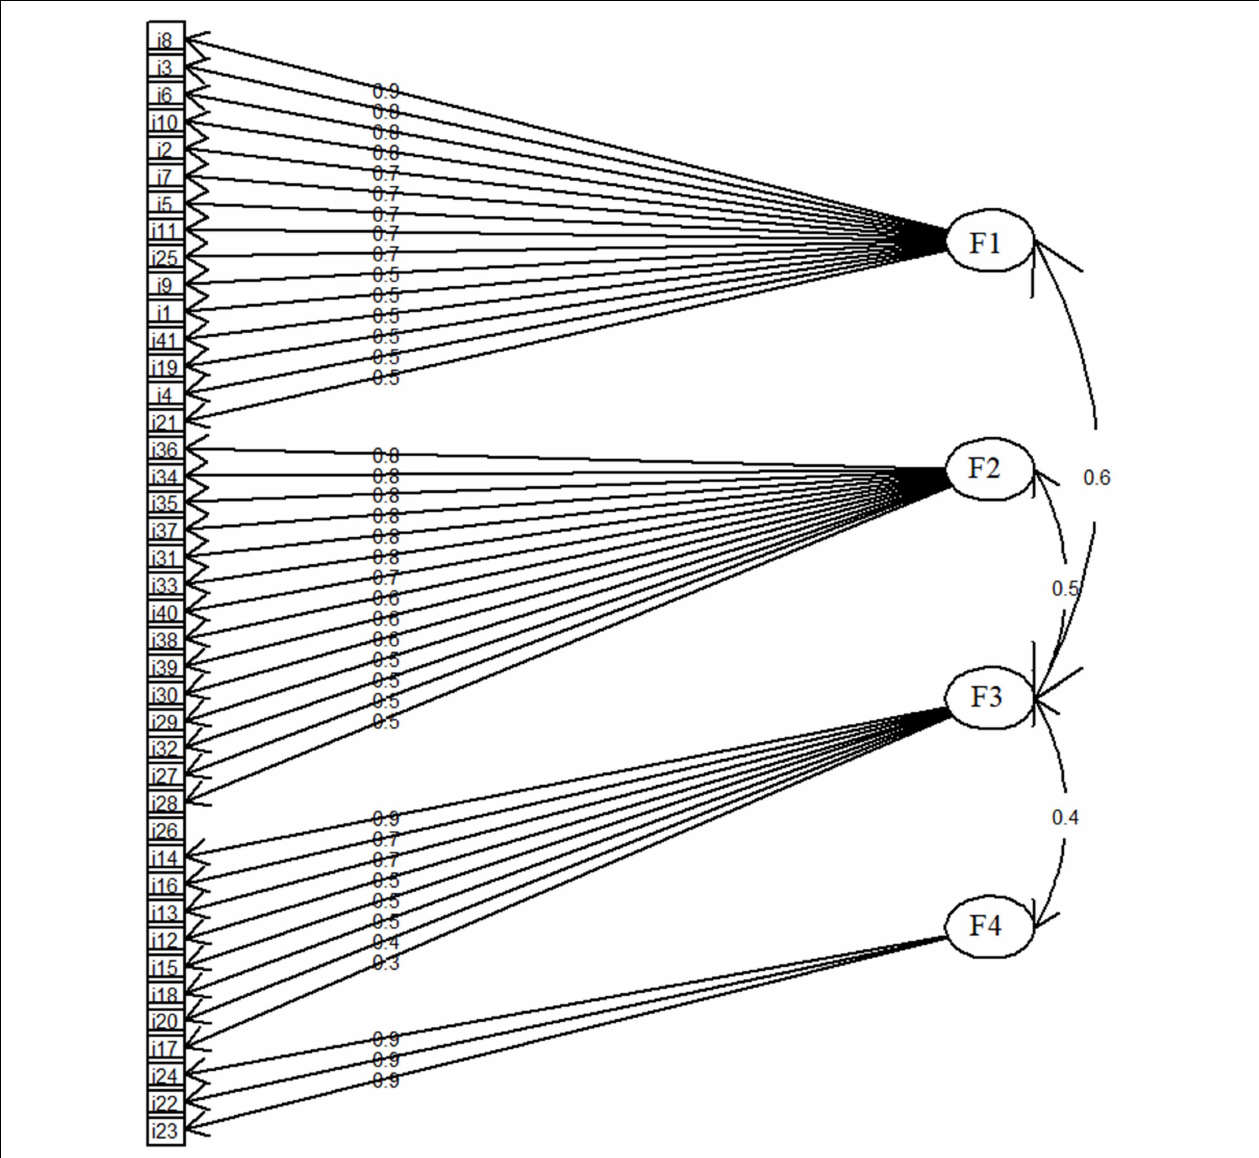
FIGURE 1 | Factor loadings for music listening during pandemics. Fl, negative mood management; F2, cognitive function; F3, positive mood management; F4, physical involvement. All the questionnaire items are displayed in Supplementary Table 4